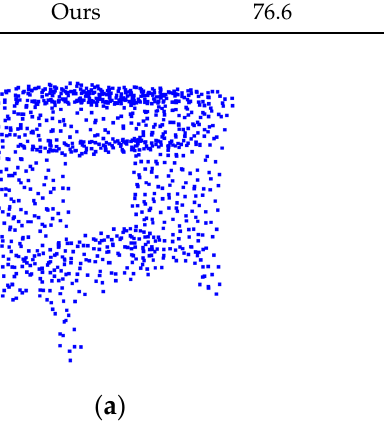
Figure 6. The example of a cabinet point cloud of ModelNet and ScanObjectNN. ( a ) ModelNet. ( b ) ScanObjectNN.